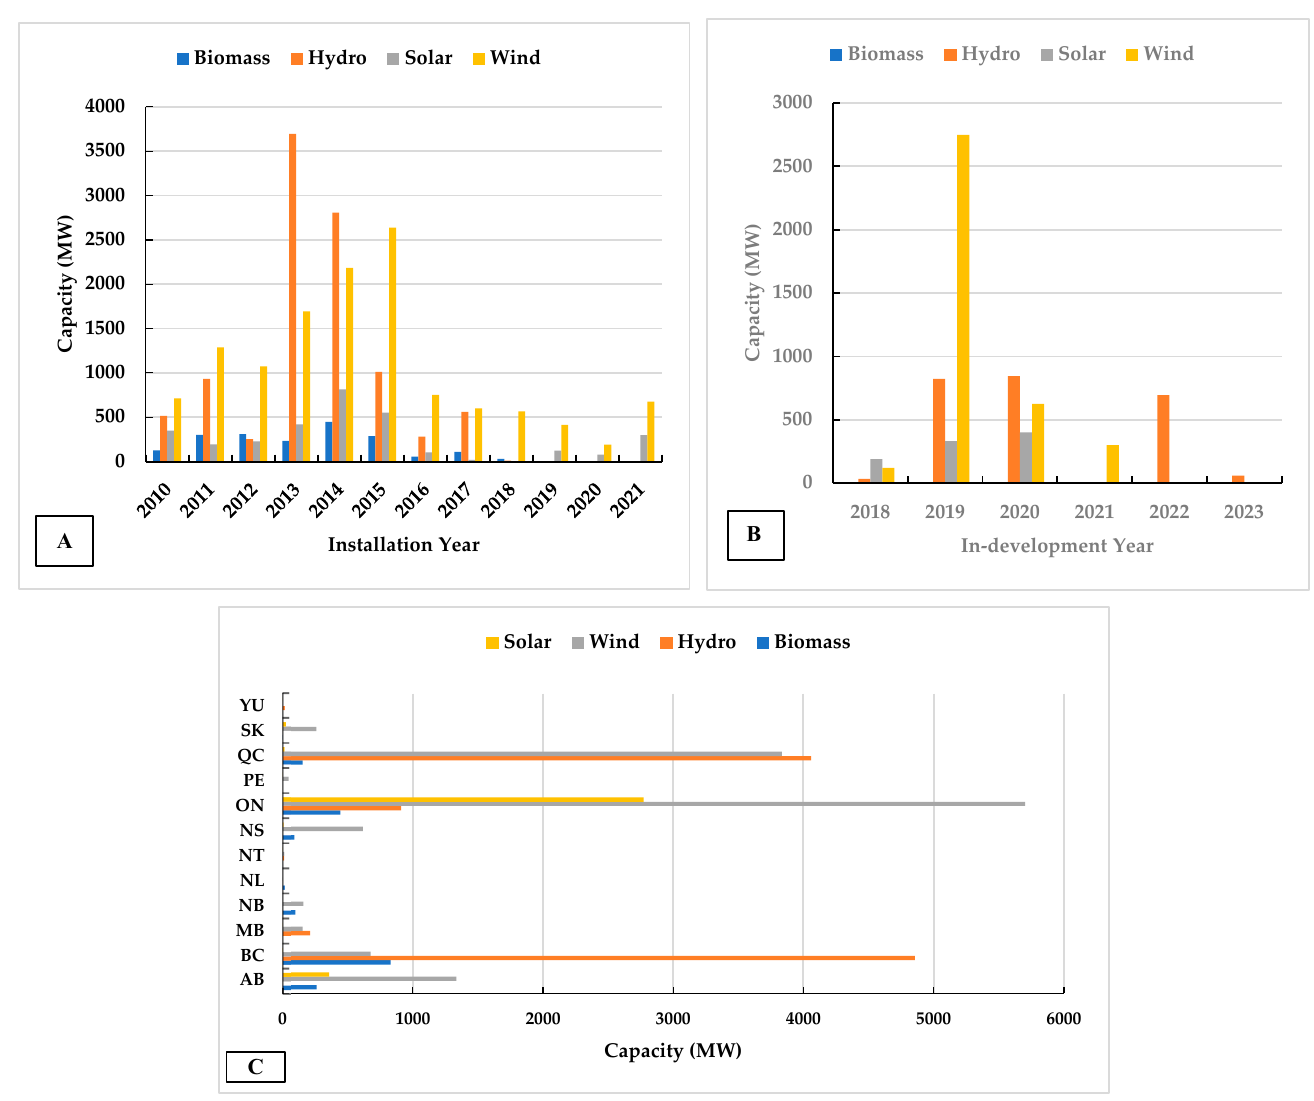
Figure 4. Total renewable energy growth capacities: ( A ) In operation, ( B ) In development, and ( C ) Province capacity [31,33,88]. AB: Alberta; BC: British Columbia; MB: Manitoba; NB: New Brunswick; NL: Newfoundland and Labrador; NT: Northwest Territories; NS: Nova Scotia; ON: Ontario; PE: Prince Edward Island; QC: Quebec; SK: Saskatchewan; YU: Yukon.